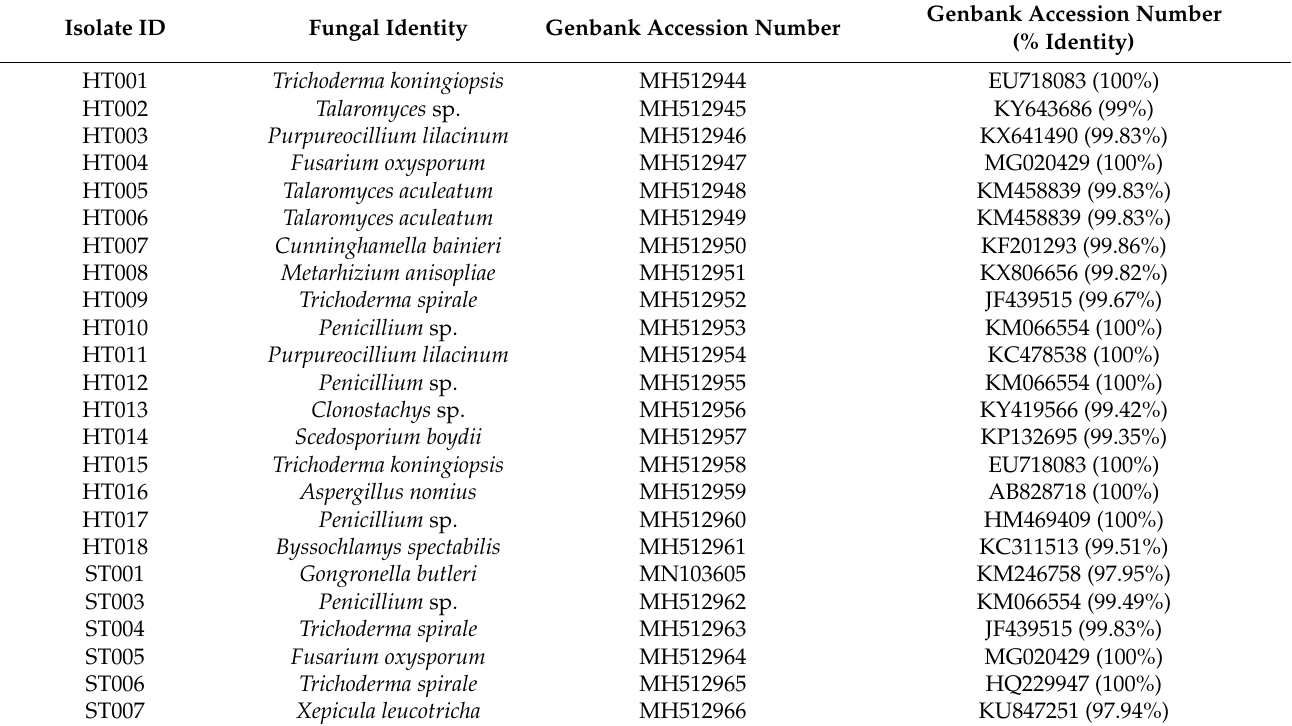
Table 3. Fungal community associated with the soil sampled in this study from a rubber plantation at the Rubber Research Institute of Malaysia and its identity percentage from the NCBI website. Isolate